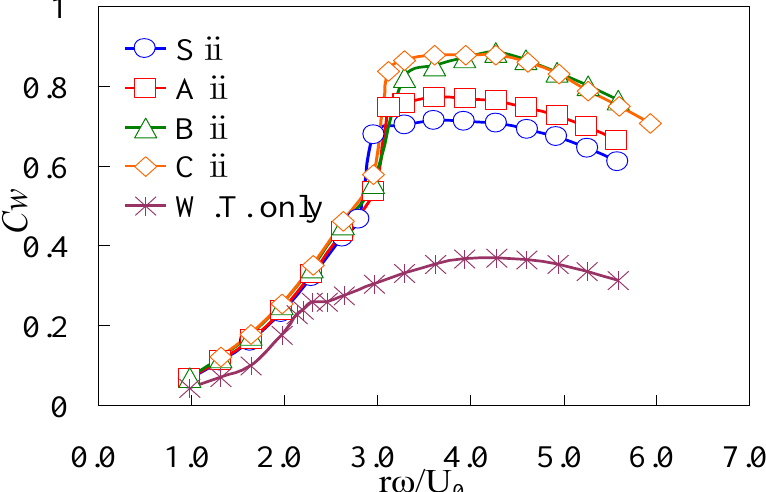
Figure 11. Power coefficients C The brim height is 10%, i.e. , h = 0.1 D .